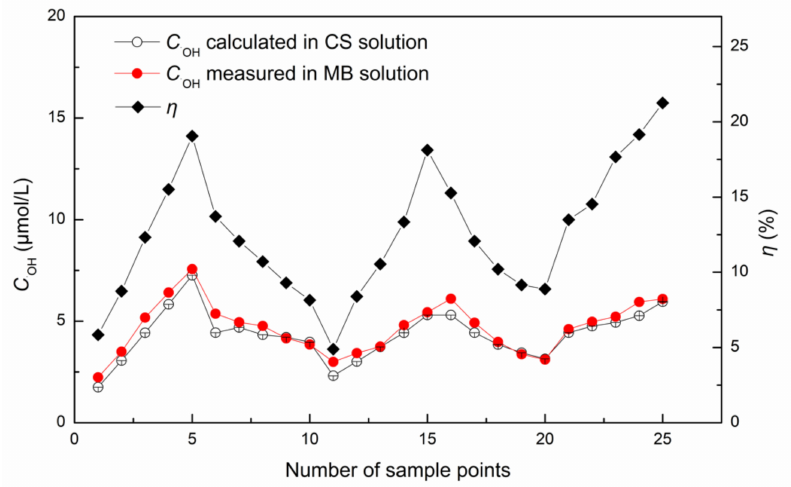
Figure 12. Comparison of measured · OH yield in MB solution, calculated · OH yield in CS solution, and intrinsic viscosity reduction rate of CS. Experimental points: 1–5 for cavitation time, 10–90 min; 6–10 for throat diameter, 0.5–0.9 mm; 11–15 for inlet pressure, 0.1–0.5 MPa; 16–20 for solution volume, 120–240 mL; 21–25 for temperature, 30–70 ◦